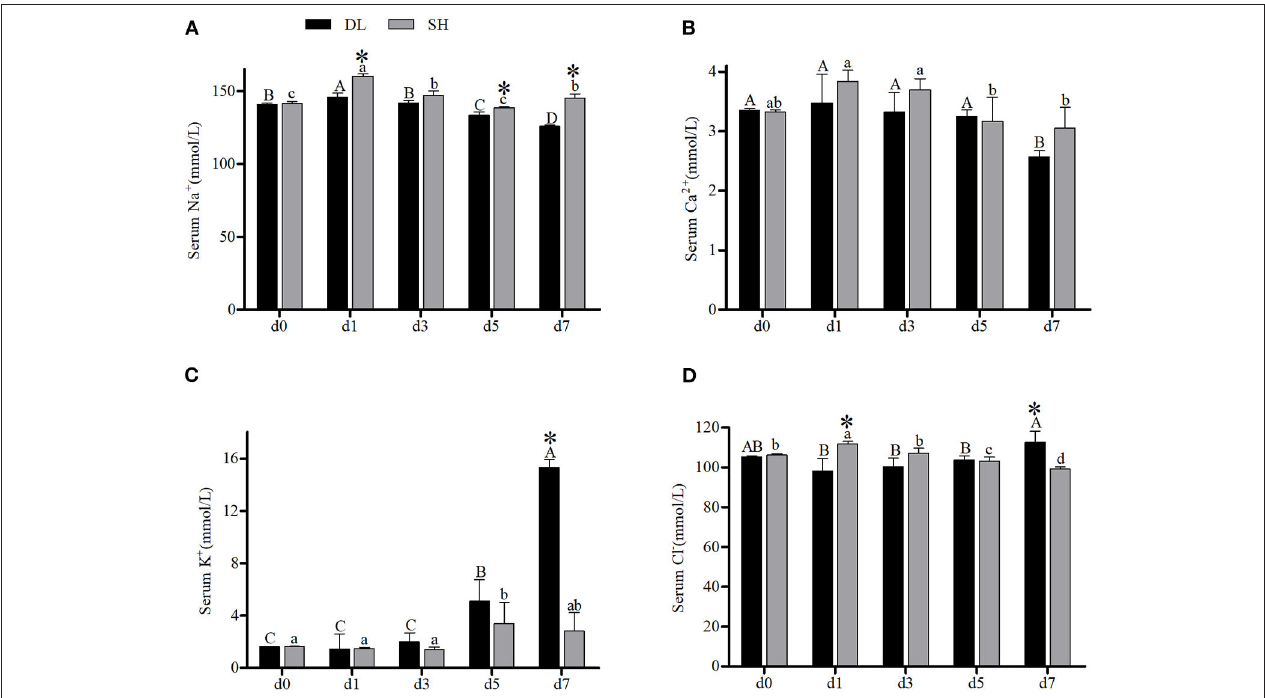
FIGURE 1 | Serum ion concentrations ( n = 9) of DL (the alkali form introduced from Lake Dali Nor) and SH (the freshwater form introduced from Songhua River) fish forms acclimated to AW (alkaline water) for 7 days. Different uppercase letters indicate significant differences within DL, and different lowercase letters indicate significant differences within SH. The asterisk ( * ) denotes a significant difference in serum ionic levels found between DL and SH exposed to bicarbonate AW.